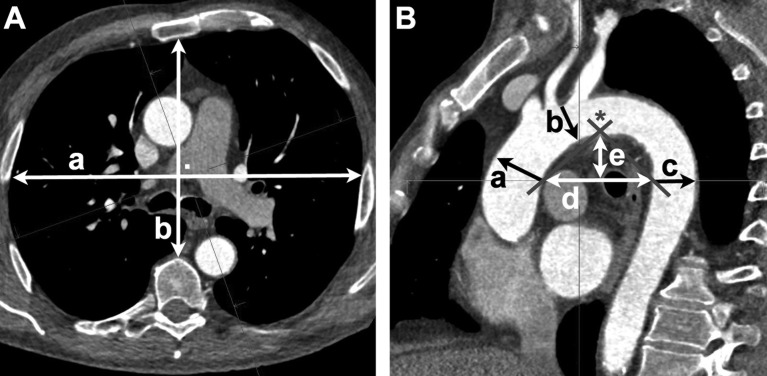
Example of measures.A + B are correspondent planes set with SyngoVia imaging software (Siemens Healthcare AG, Forchheim, Germany). A) Maximum width (a) and depth (b; perpendicular to a) of thorax on the plane of tracheal bifurcation. B) Diameters of Aorta ascendens (a), aortic arch (b), and Aorta descendens (c). Aortic arch index (AAI) is the distance (d) of the inner walls of the ascendent and descendent aorta. The height (e) was measured perpendicular to (d) at the highest point of arch closest to the mid of (d). At the top of the delineated triangle, the aortic arch angle (AAA; *) was measured.